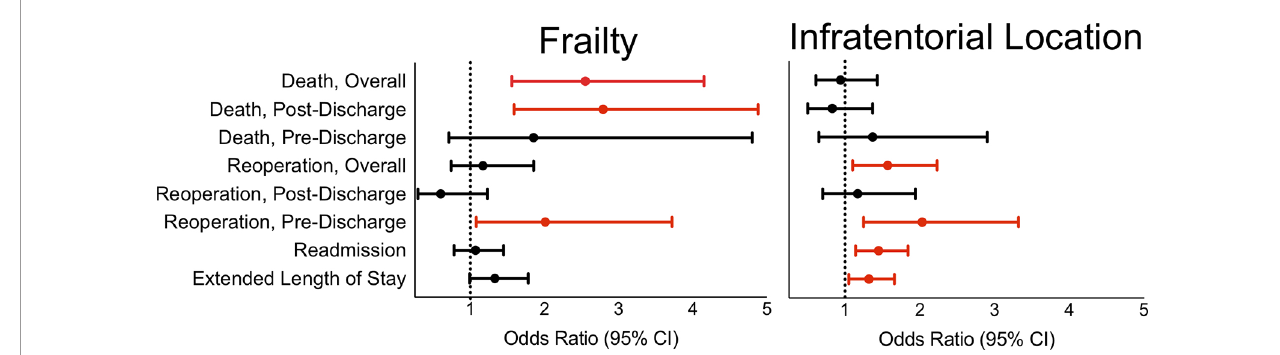
FIGURE 2 | In reference to supratentorial approaches, infratentorial surgical approach is associated with length of stay over 7 days, 30-day overall and pre- discharge reoperation, and unplanned readmission. In reference to non-frailty, frailty is associated with 30-day pre-discharge reoperation as well as overall and post-